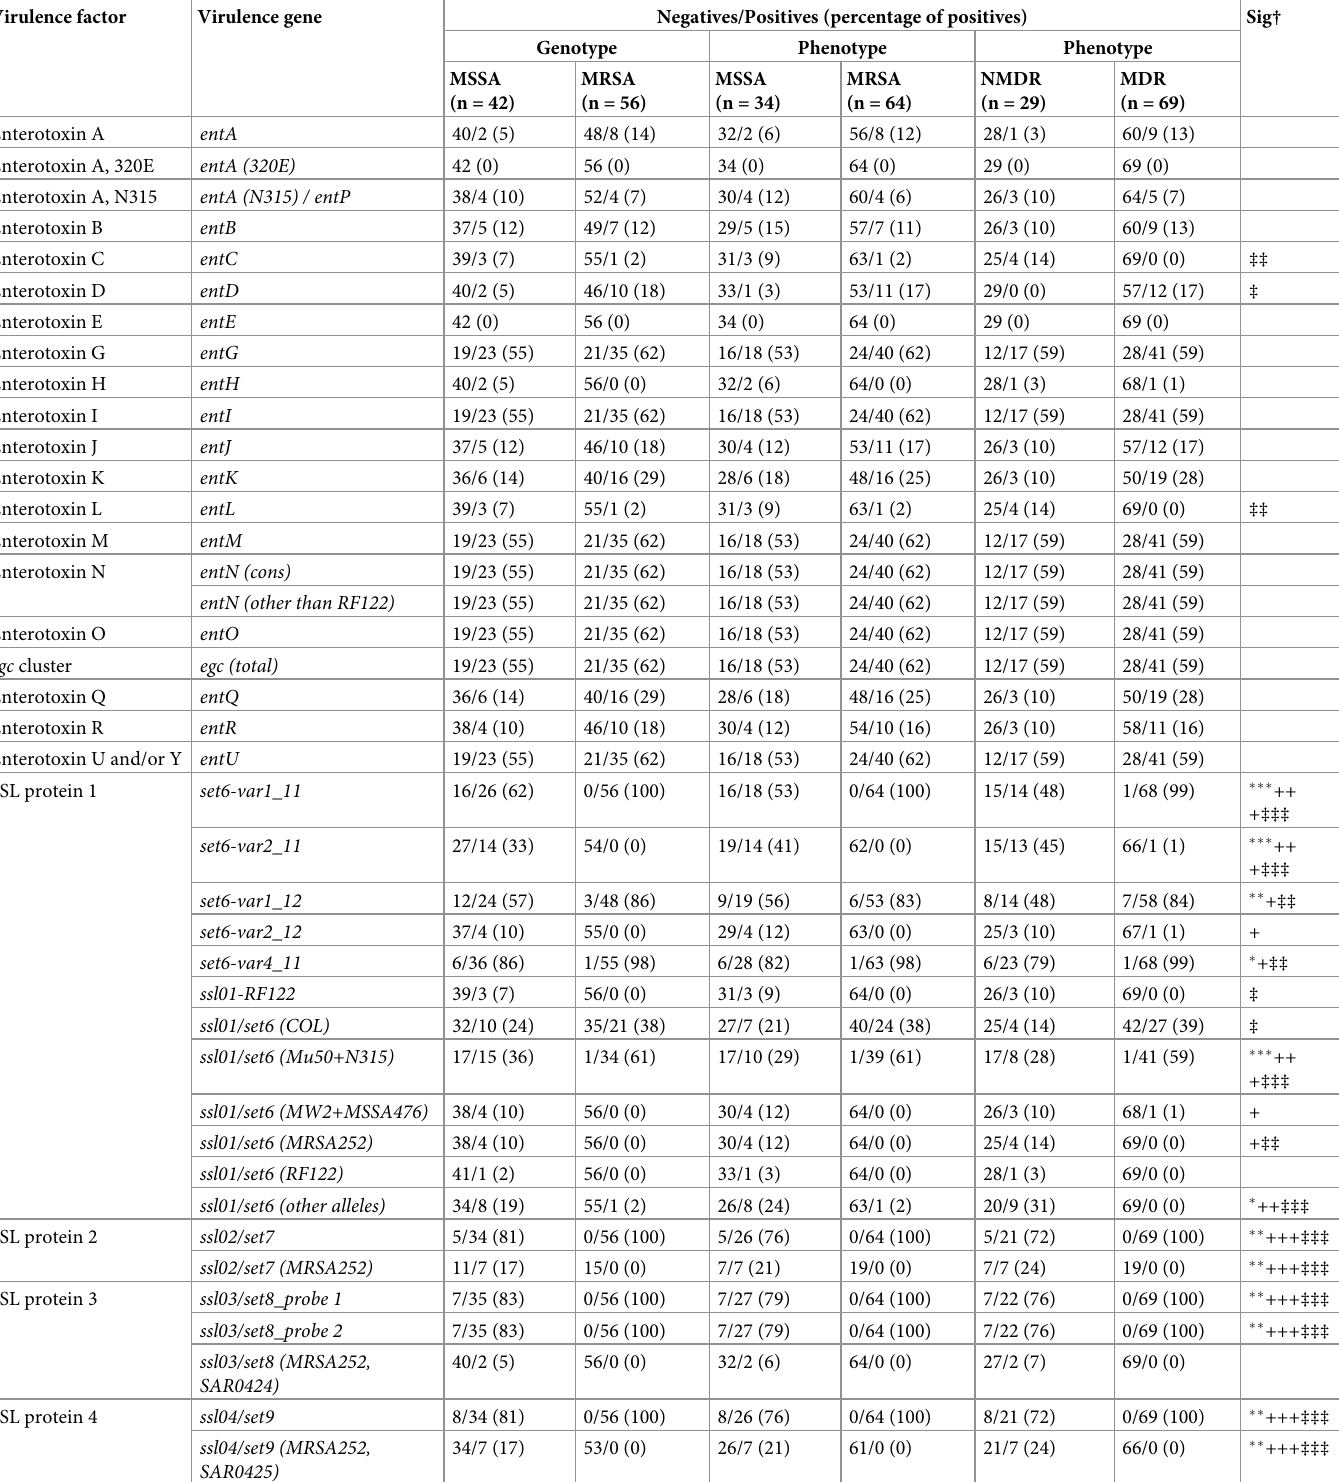
Table 1. Distribution of virulence factors among methicillin and multidrug resistance